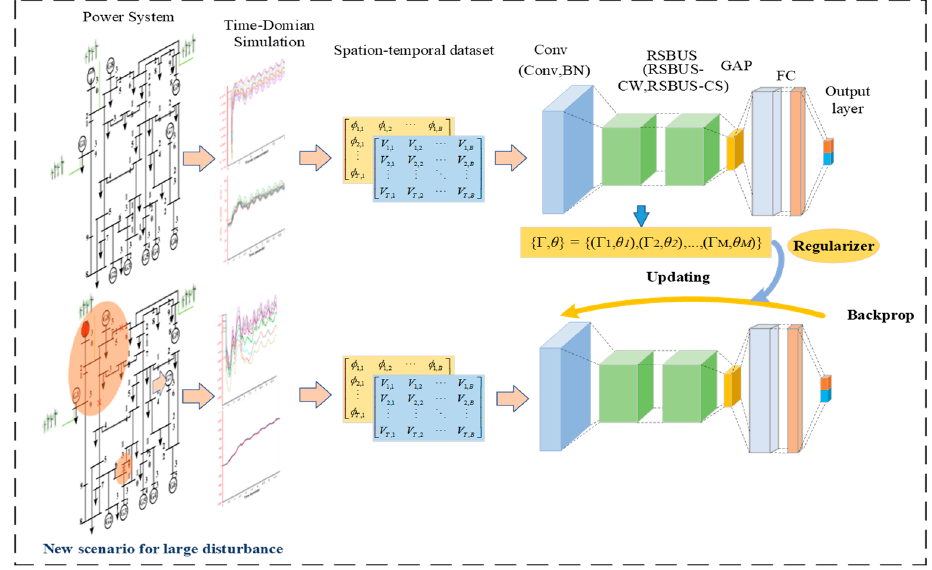
Figure 5. A framework based on SCP-DRSN for transient stability.